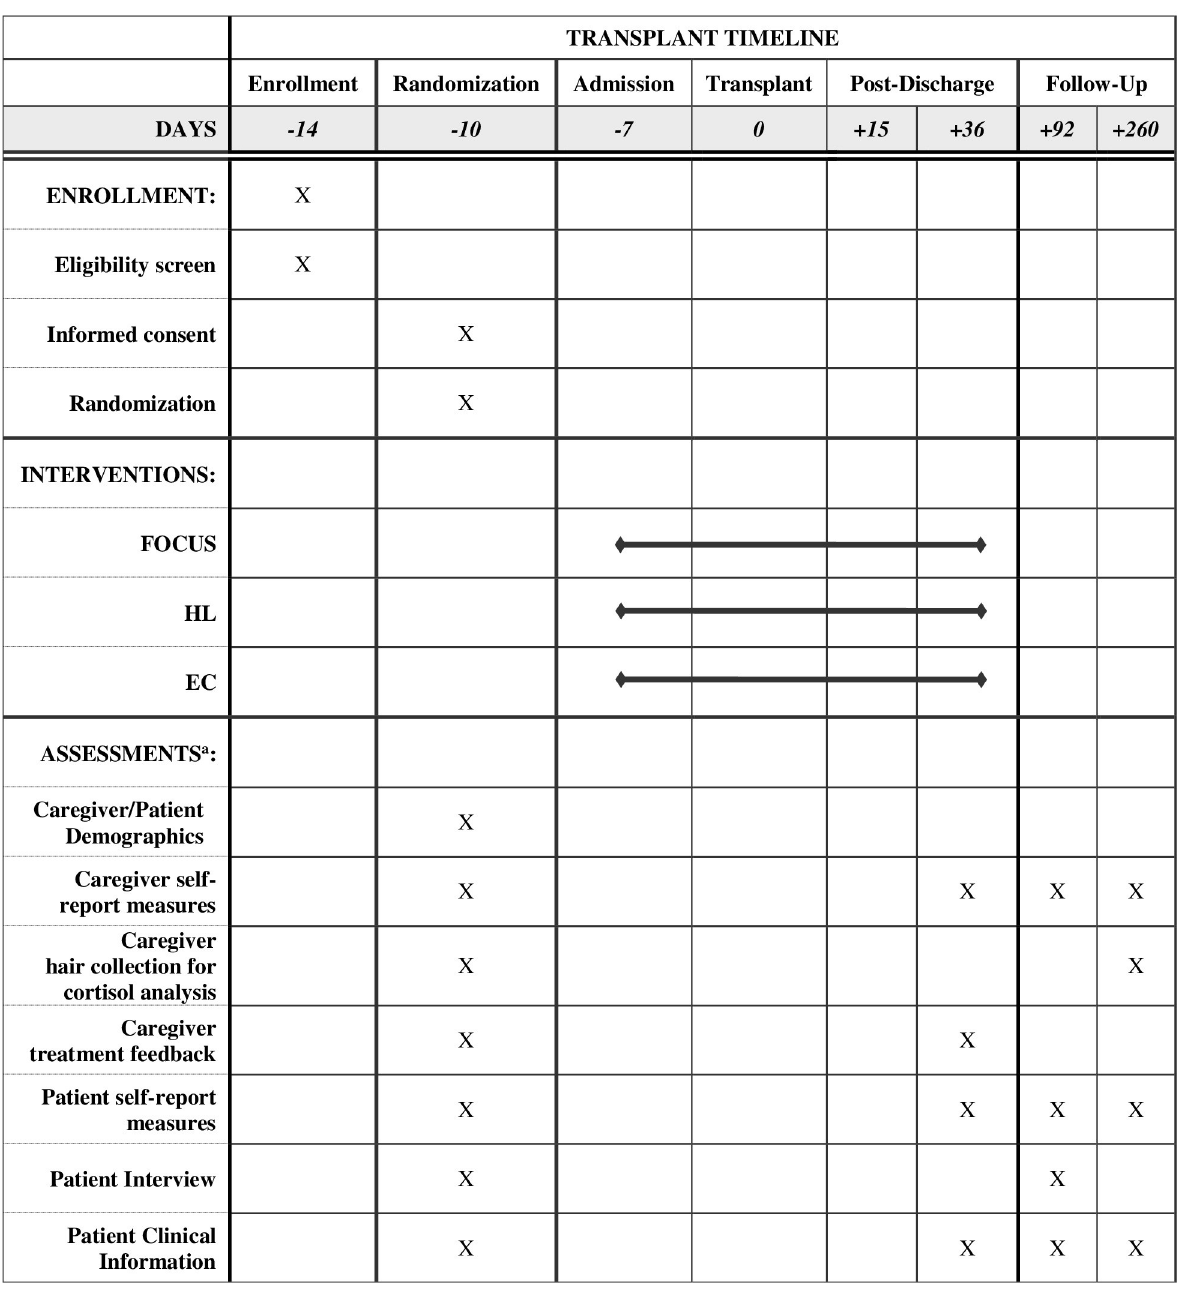
Fig 1. Schedule of enrollment, interventions, and assessments. Note. a See Table 4 for the details. FOCUS = Mindfulness Treatment; HL = Healthy Living Treatment; EC = Enhanced Care.